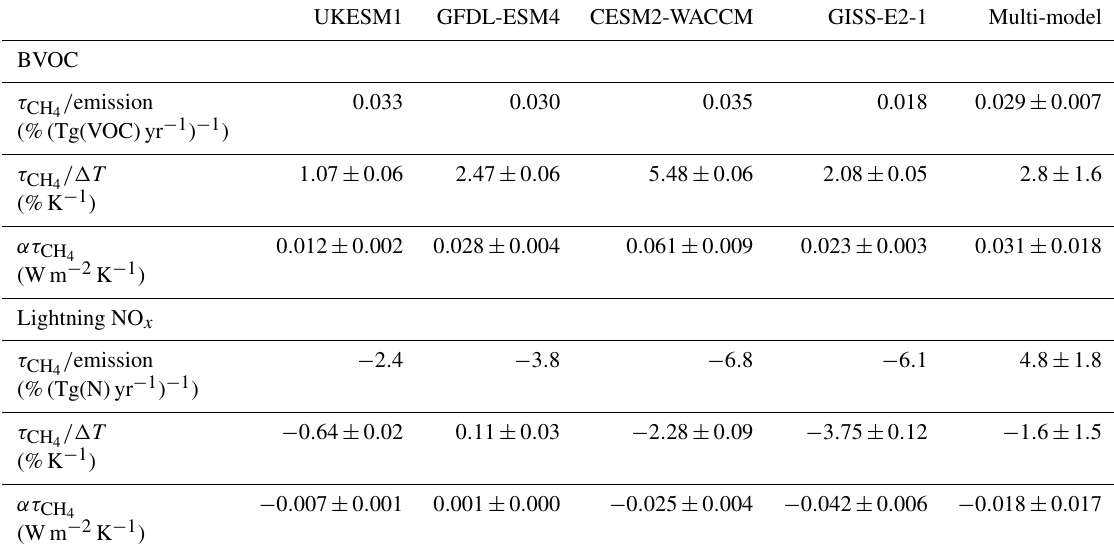
Table 12. Percentage change in methane lifetime for BVOC and lightning NO x emissions. Estimated change in lifetime following changes in BVOC and NO x emissions from the 4xCO2 experiment. α values are calculated assuming a radiative efficiency of 0.015Wm − 2 % − 1 . Uncertainties for each model assume a 14% uncertainty in the methane radiative efficiency (Etminan et al., 2016). Uncertainties in the multi-model results are the standard deviation across the models.